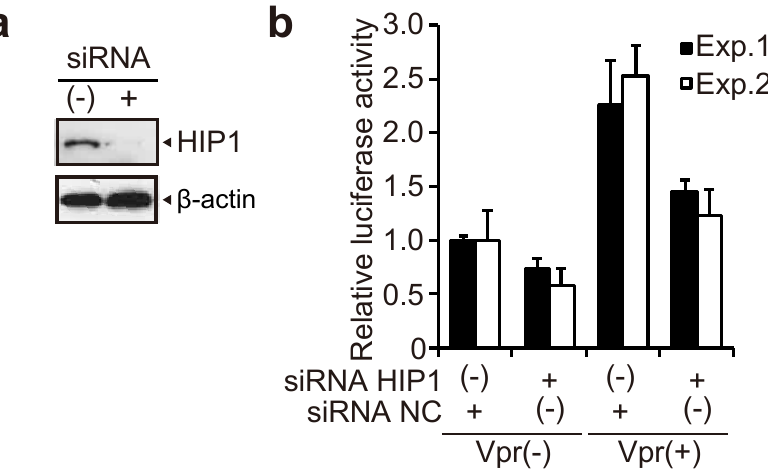
Figure 5. HIP1 enhances HIV-1 infection in macrophages in a Vpr-dependent manner. Monocytes isolated from PBMCs of human healthy donor were subsequently differentiated into macrophages by addition of M-CSF, followed by their transfection with 50 nM HIP1 (siRNA#2; siRNA HIP1) and control siRNA (siRNA NC). ( a ) At 48-h post-transfection, cells were lysed and subjected to 6% SDS-PAGE and Western blotting using the anti-HIP1 mAb and anti- β -actin mAb. The positions of HIP1 and β -actin are indicated. ( b ) At 24-h post-transfection, cells were infected with 4 ng p24 VSV-G-pseudotyped-HIV-1 or -HIV-1 Δ Vpr. At 6-days post-infection, cells were lysed, and infectivity was determined by measuring luciferase activity. Data represent the mean ± SD of triplicate wells.